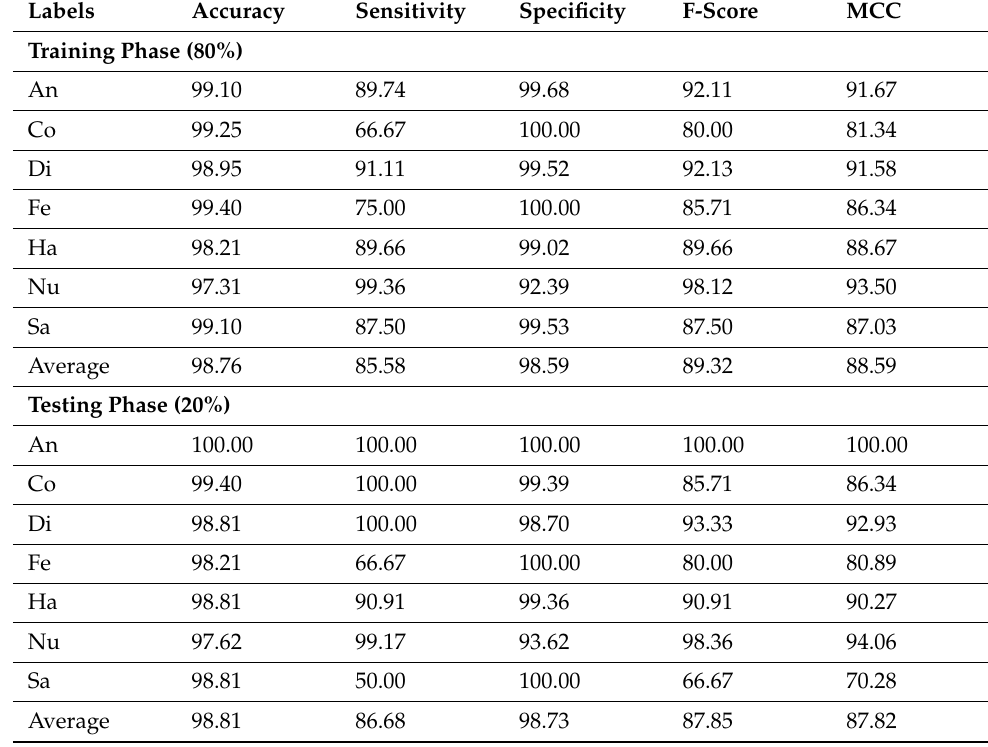
Table 4 establishes the overall FER results of the RFER-EADL approach on 20% of TS data and 80% of TR data. Figure 8 shows the FER results of the RFER-EADL technique on 80% of TR data. The effects specify that the RFER-EADL algorithm recognized all facial expressions accurately. For example, for class A, the RFER-EADL methodology provided accu y of 99.10%, sens y of 89.74%, spec y of 99.68%, an F score of 92.11%, and an MCC of 91.67%.